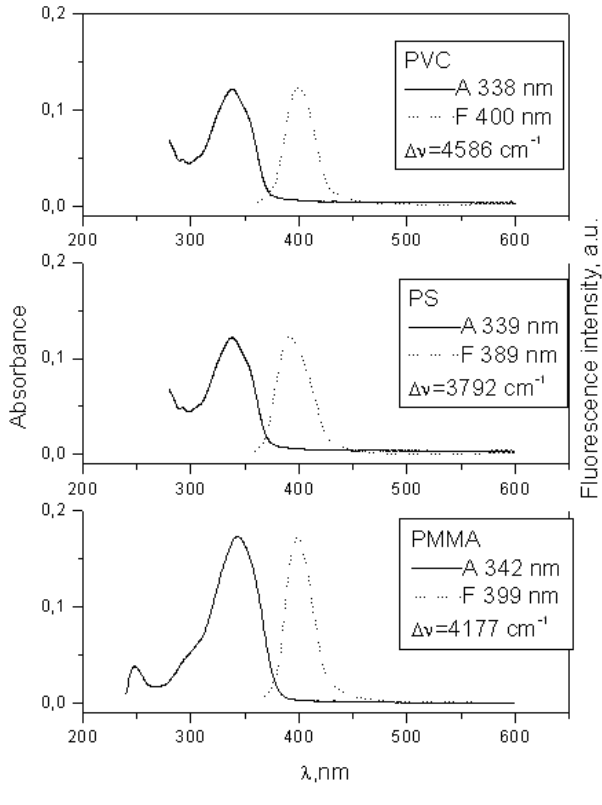
Figure 5 . Absorption and fluorescence spectra of 8 in PMMA, PS and PVC at 0.002 mol kg − 1